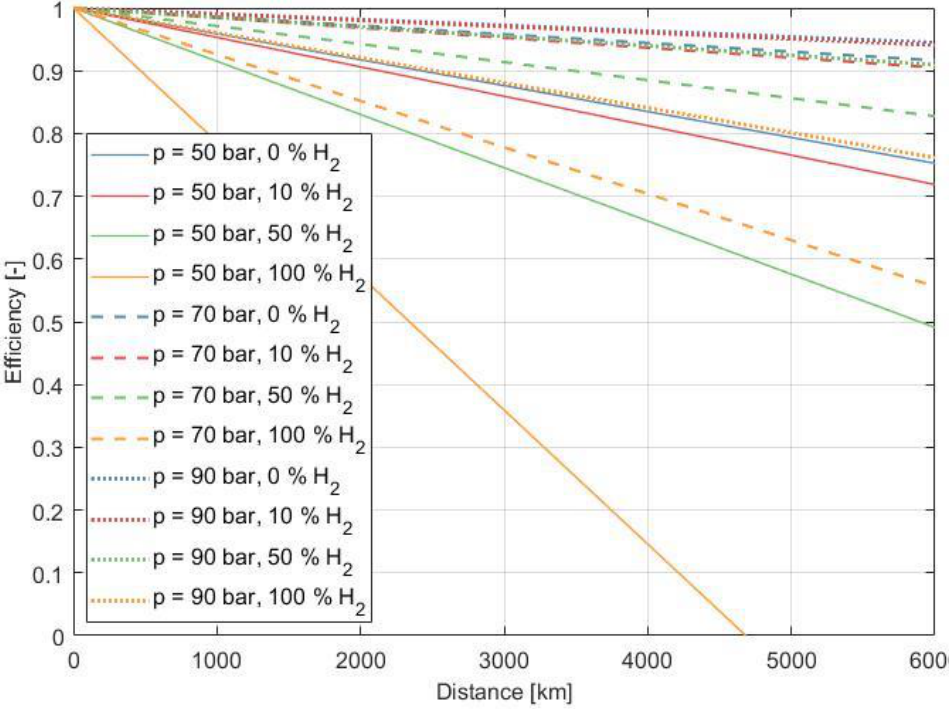
Figure 10. Influence of operating pressure on transport efficiency.